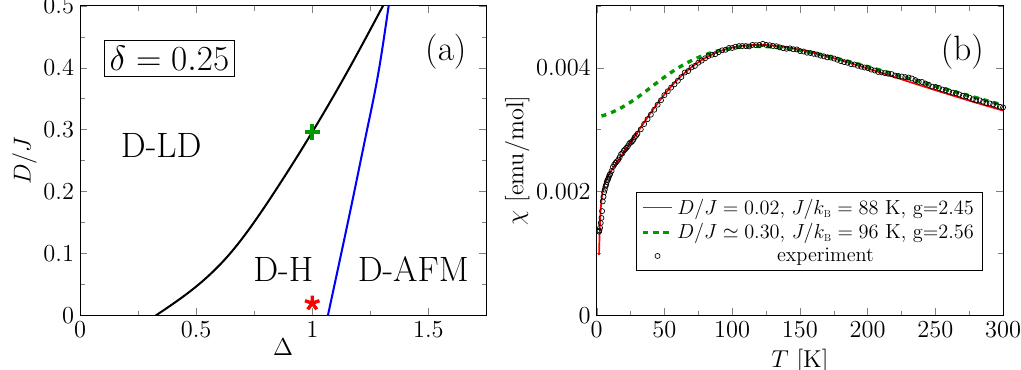
Figure 5: (a) Ground-state phase diagram of the model (2) for δ = 0.25. The red star denotes the parameter set corresponding to the Ni compound [ Ni(333- ] (ClO tet)( µ -N ) ) , and the green cross gives the Gaussian transition point n n 3 4 [ ( D / J ) (cid:39) 0.296 ] for fixed ∆ = 1. (b) Temperature dependence of the magnetic sus- c ceptibility of the powdered sample for [ Ni(333-tet)( µ -N from Ref. [ 19 ] . The red solid line is the iTEBD data for ∆ = 1, D / J = 0.02 and δ = 0.25 with J / k = 88 K and g = 2.45. For comparison, we also show the iTEBD B result at the Gaussian transition for fixed ∆ = 1 (green dashed